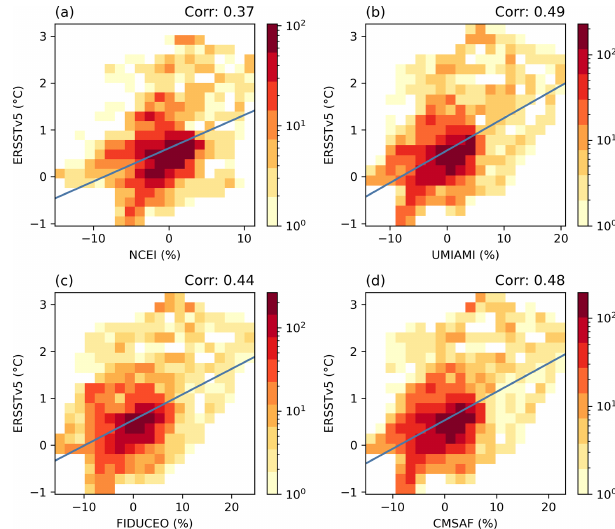
Figure 8. Similar to Fig. 7 except for UTH anomalies vs. ERSSTv5 anomalies.